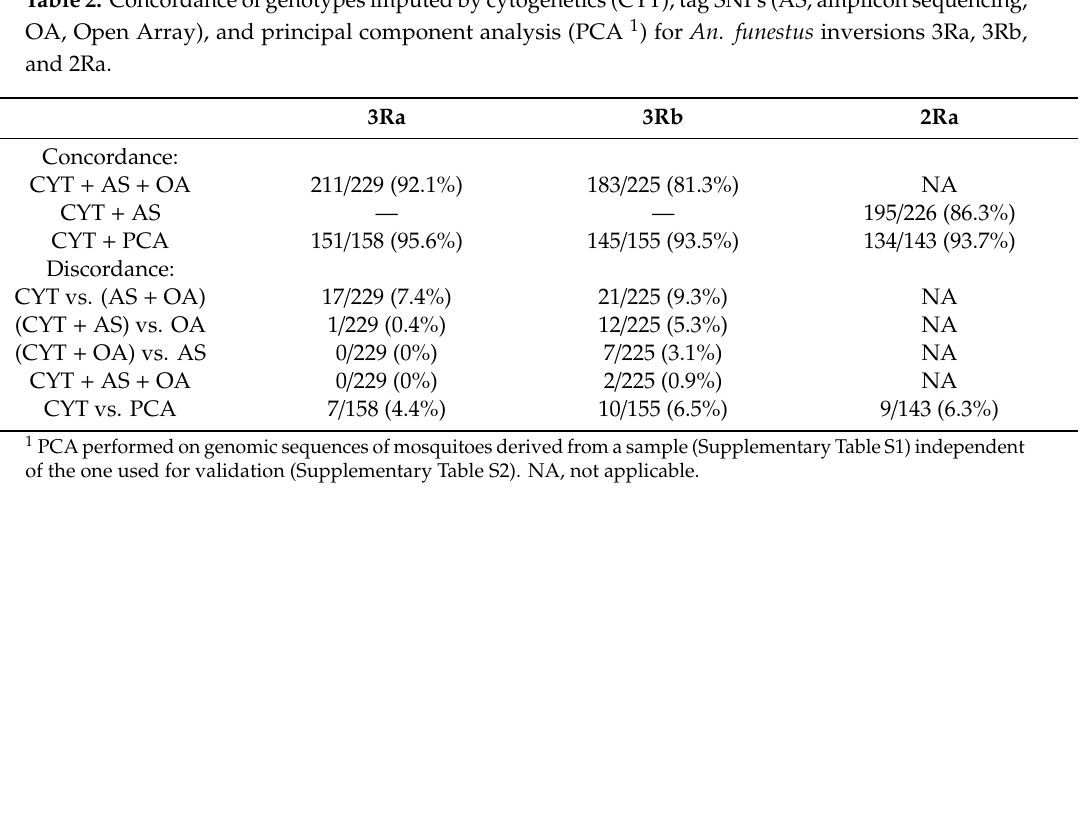
Table 2. Concordance of genotypes imputed by cytogenetics (CYT), tag SNPs (AS, amplicon sequencing; OA, Open Array), and principal component analysis (PCA 1 ) for An. funestus inversions 3Ra, 3Rb, and